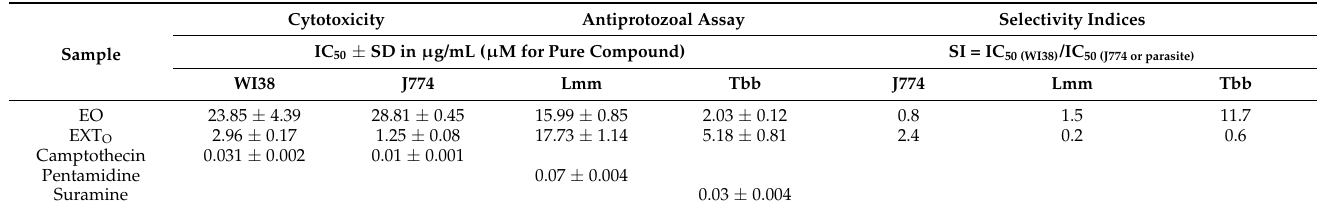
Table 5. The cytotoxicity (W138 and J774) and in-vitro activity of P. porelloides EO and EXT O against Leishmania mexicana mexicana (Lmm) and Trypanosoma brucei brucei